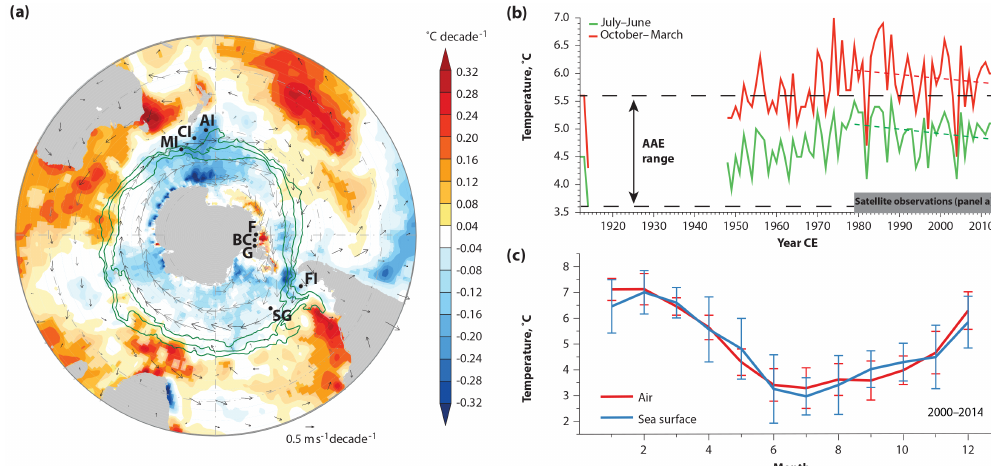
Figure 1. Ocean–atmosphere coupling in the Southern Hemisphere. (a) Significant ( p < 0 . 05) austral summer (December–February) sea surface temperature (SST ◦ Cdecade − 1 ; shading) and 925hPa winds (vectors) trends since 1979. Temperatures based on SSTs from the HadISST dataset (Rayner et al., 2003); winds from ERA-Interim (Dee et al., 2011). Key sites discussed in text are shown: Macquarie Island (MI), Campbell Island (CI), Antipodes Island (AI), Ferrigno (F), Bryan Coast (BC), Gomez (G) (Thomas et al., 2008, 2015), Falkland Islands (FI), and South Georgia (SG) (Turney et al., 2016a). Overlaid in green are the three main fronts of the Antarctic Circumpolar Current (Sallée et al., 2012). (b) Annual (July–June) and spring–summer (October–March) air temperatures at Macquarie Island. Dashed lines denote range of the Australasian Antarctic Expedition temperatures (AAE; CE1912–1915). Period of satellite observations (a) shown by grey bar; dashed coloured lines denote trend in temperatures across the satellite period. (c) Monthly Macquarie Island air (red line) and sea surface temperatures (blue line) (with 1 σ ) demonstrating tight coupling between atmospheric temperature and SSTs